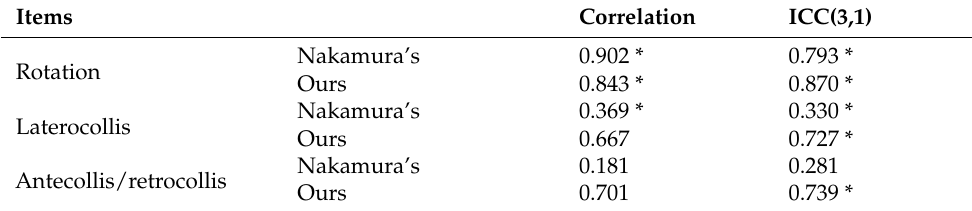
Table 3. Validity and accuracy of our method and the previous